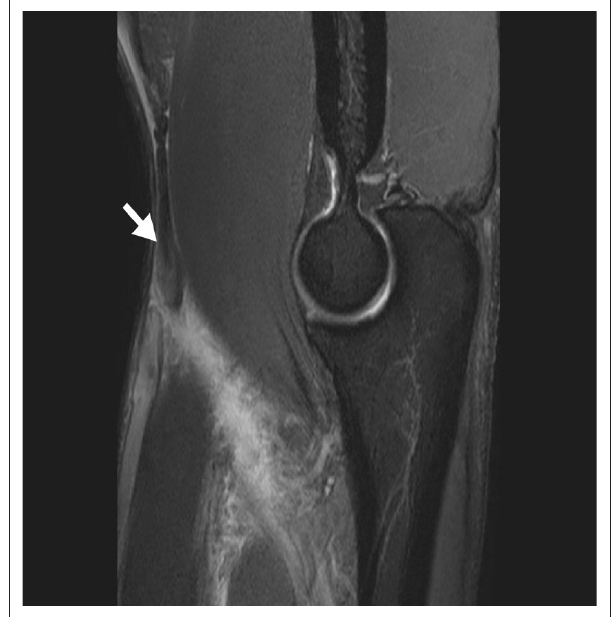
FIGURE 4: Magnetic resonance image (MRI) T2 FS in the sagittal plane, demonstrating complete tear of the distal biceps tendon